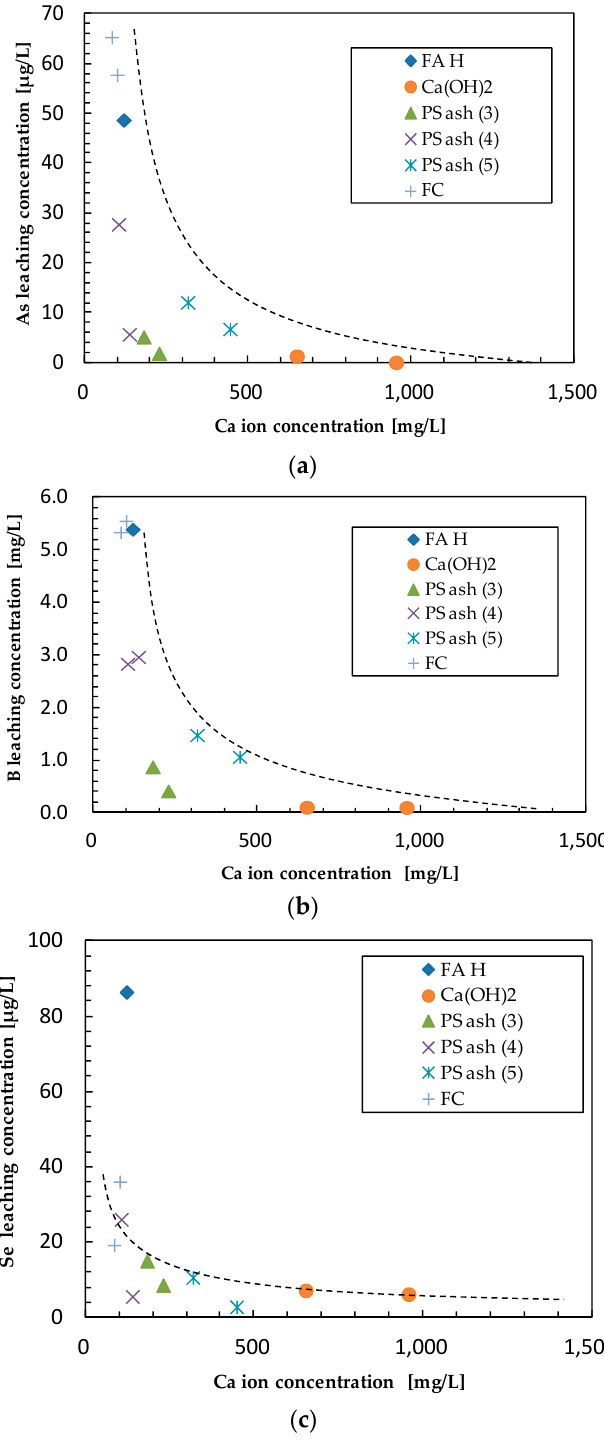
Figure 6. Relationship between the Ca ion leaching concentration and trace elements leaching concentration of five kinds of additives: ( a ) arsenic; ( b ) boron; and ( c ) selenium.